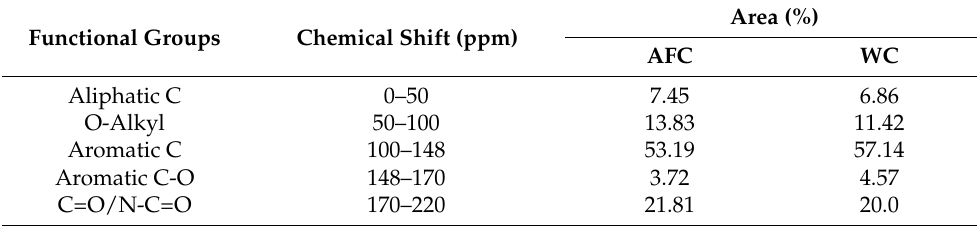
Table 4. Percentage distribution of carbon in WC and AFC determined by solid-state 13 C NMR spectroscopy.